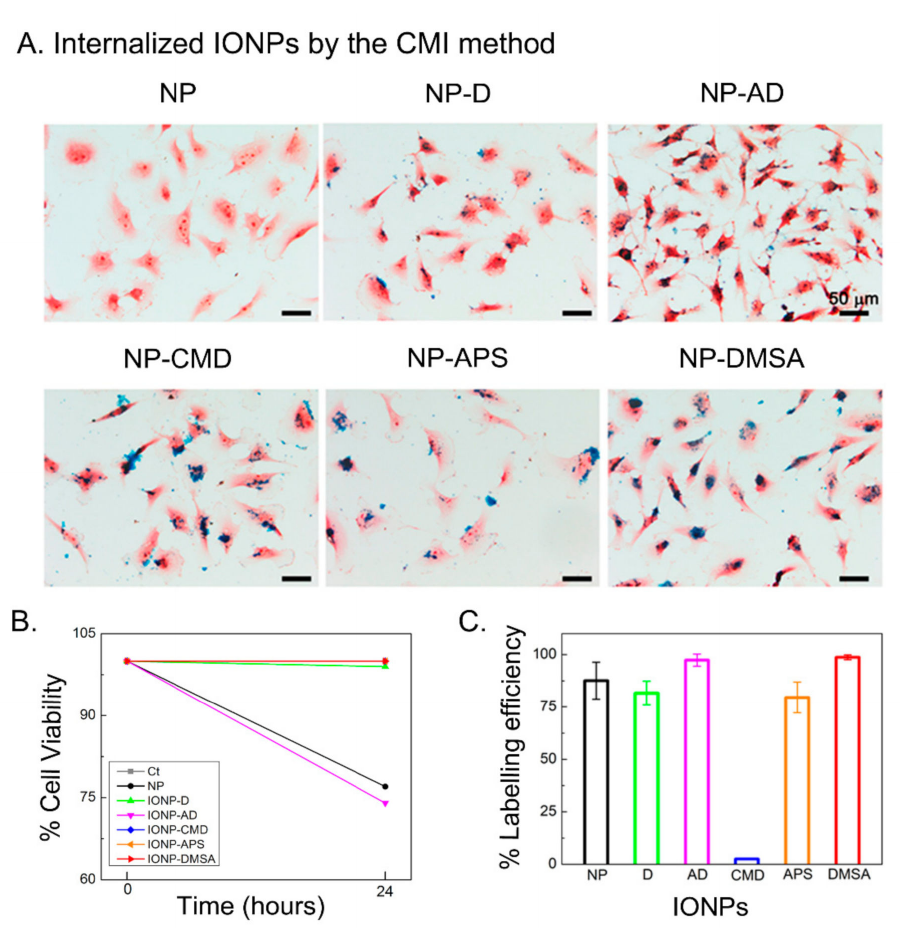
Figure 2. ( A ) Optical microscopy images of U373 cells after IONPs internalization through the CMI method followed by Prussian blue staining. ( B ) Cell viability obtained from resazurin assay. ( C ) IONPs labelling efficiency after CMI. Error bars represent standard